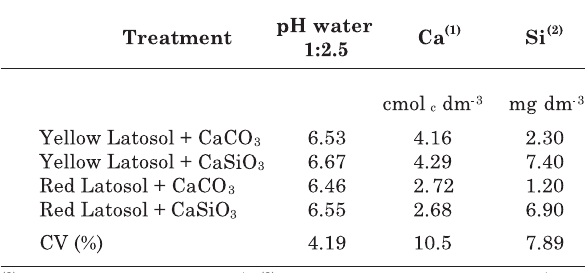
Table 1. Values of pH in water, Ca and Si content after incubation of soils with liming materials